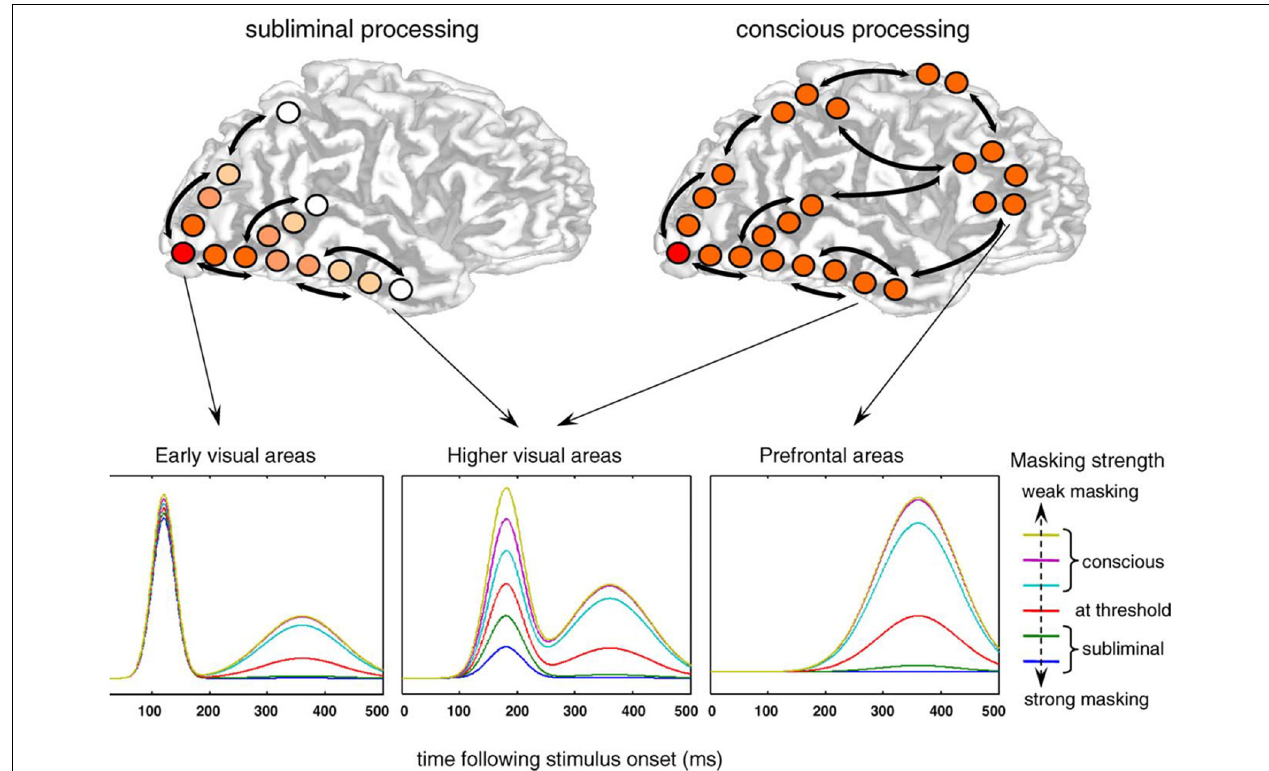
FIGURE 3 | Consciousness is not correlated with early event-related potentials. This electrophysiological study of visual processing concluded that early event-related potentials (reflecting more primary sensory processing)